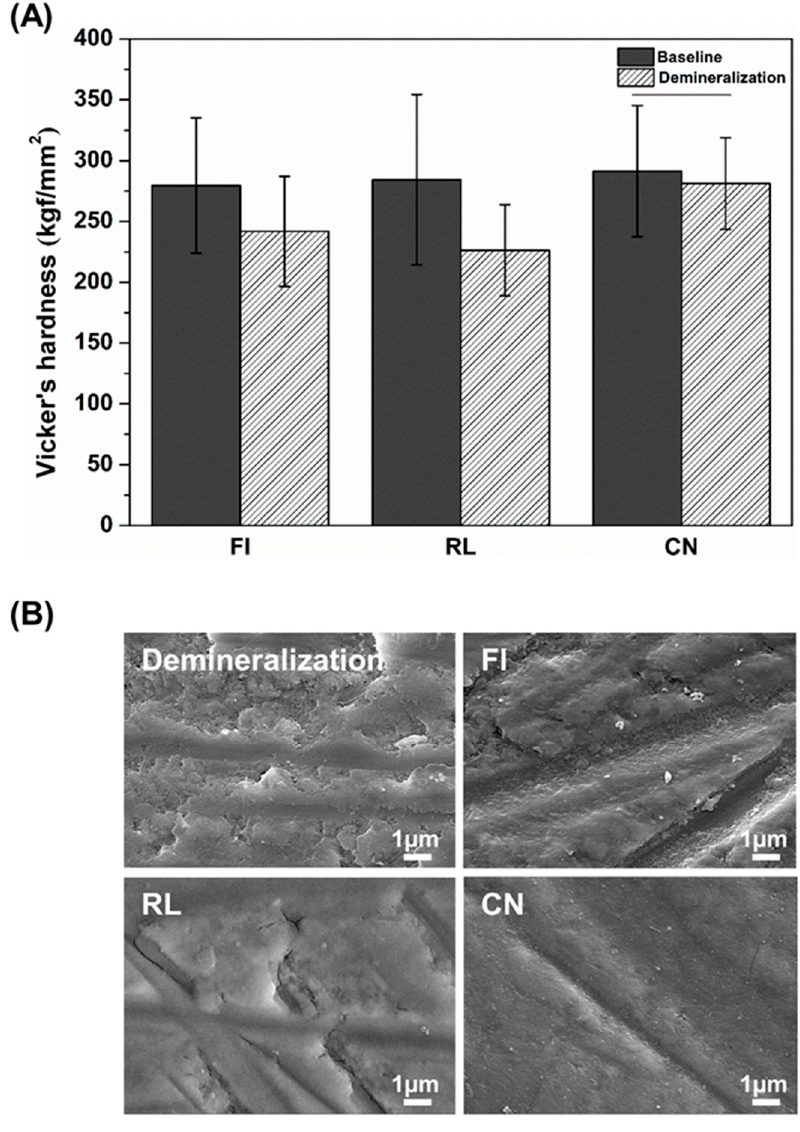
Figure 4. Microhardness of the enamel surface filled with each restorative material ( A ). Each value indicates the mean of 10 measurements, and the error bars represent the standard deviation of the (mean ± standard deviation; n = 10). Horizontal bar: no significant difference before and after immersion in demineralization ( p > 0.05). Representative images of enamel surface after demineralization process ( B ).